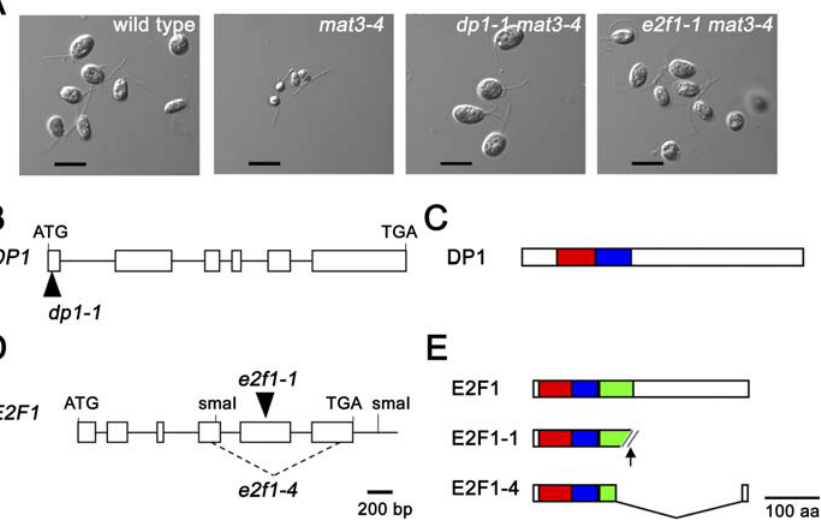
Figure 1. Suppressors of mat3–4 (A) Nomarski images of daughter cells from indicated strains. Scale bar ¼ 10 l m. (B, D) Schematic of DP1 and E2F1 loci, with exons and introns denoted by rectangles and solid lines, respectively. Translation start (ATG) and stop (TGA) codons, and SmaI cut sites are shown. Plasmid insertion sites for dp1–1 and e2f1–1 alleles are indicated by dark triangles. The deleted region of e2f1–4 genomic DNA is indicated by a dashed line. (C, E) Schematics of DP1 and E2F1 proteins showing DNA binding domains (red), dimerization domains (blue), and Marked box (green). The arrows indicate the position where the e2f1–1 insertions would interrupt the peptide sequence. For E2F1–4, part of the predicted E2F1 protein is missing due to an in-frame deletion as indicated. DOI: 10.1371/journal.pgen.0020167.g001